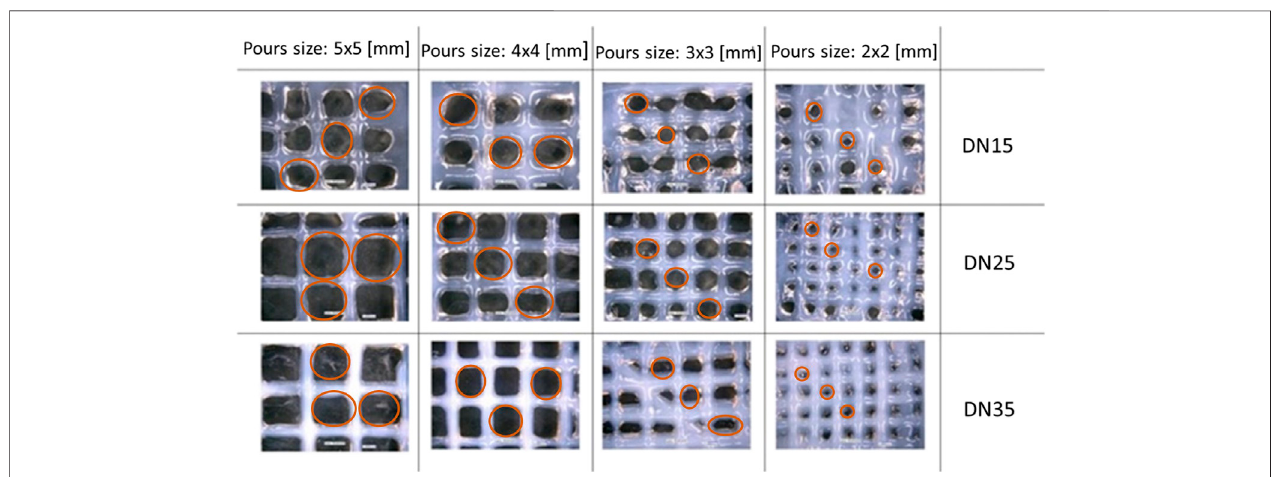
FIGURE6| Latticestructure: D =0.41 mm, H =0.240 mm,and F =2 mm/s.Markedinredaretheporesthatweretakenintoconsiderationforthemeasurements.